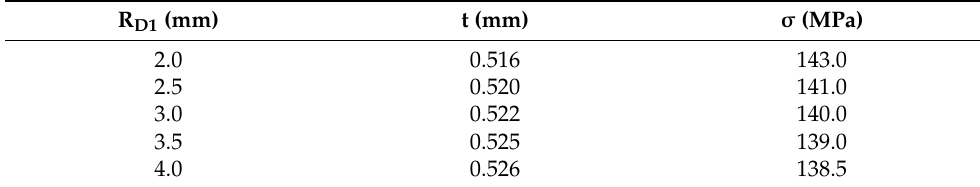
Table 4. The thickness and stress results at point F with different values of pocket radius on the bottom of